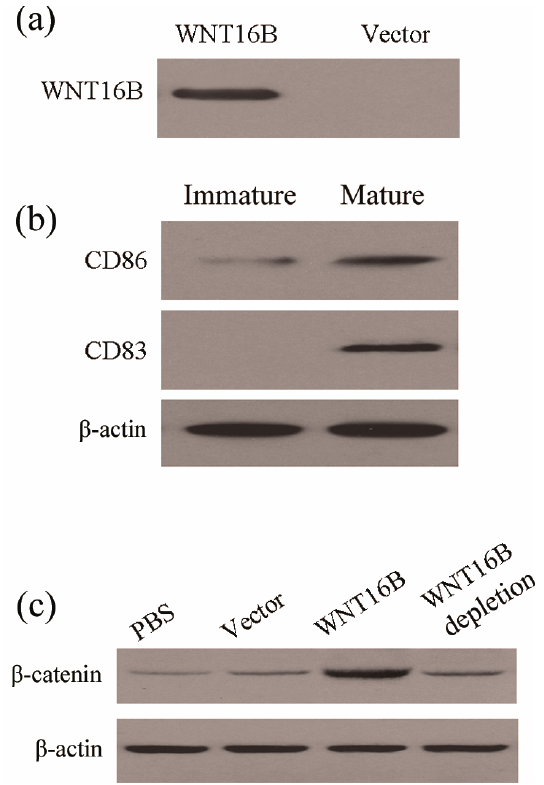
Figure 2. WNT16B from fibroblast activated β -catenin signaling in DCs (Dendritic Cells). ( a ) Western blot showed WNT16B was secreted into culture supernatant by fibroblasts after transfection of recombinant plasmid containing the WNT16B gene; ( b ) Biomarker identification of DCs by Western blot. The levels of CD86 and CD83 were obviously increased in mature DCs; and ( c ) Western blot showed β -catenin was increased in